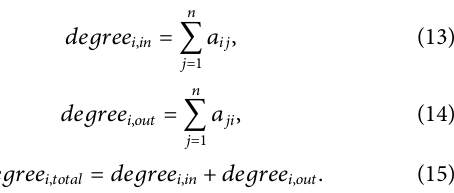
Frontiers in Physics |